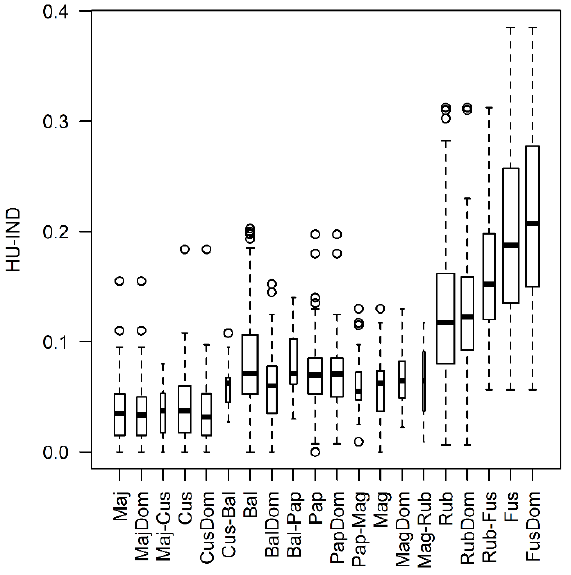
Figure 13. Boxplot of the hummock index (HU- IND) in vegetation plots, where Sphagnum moss species occurred in various combinations. See also Figure 11 for an interpretation of the classes.